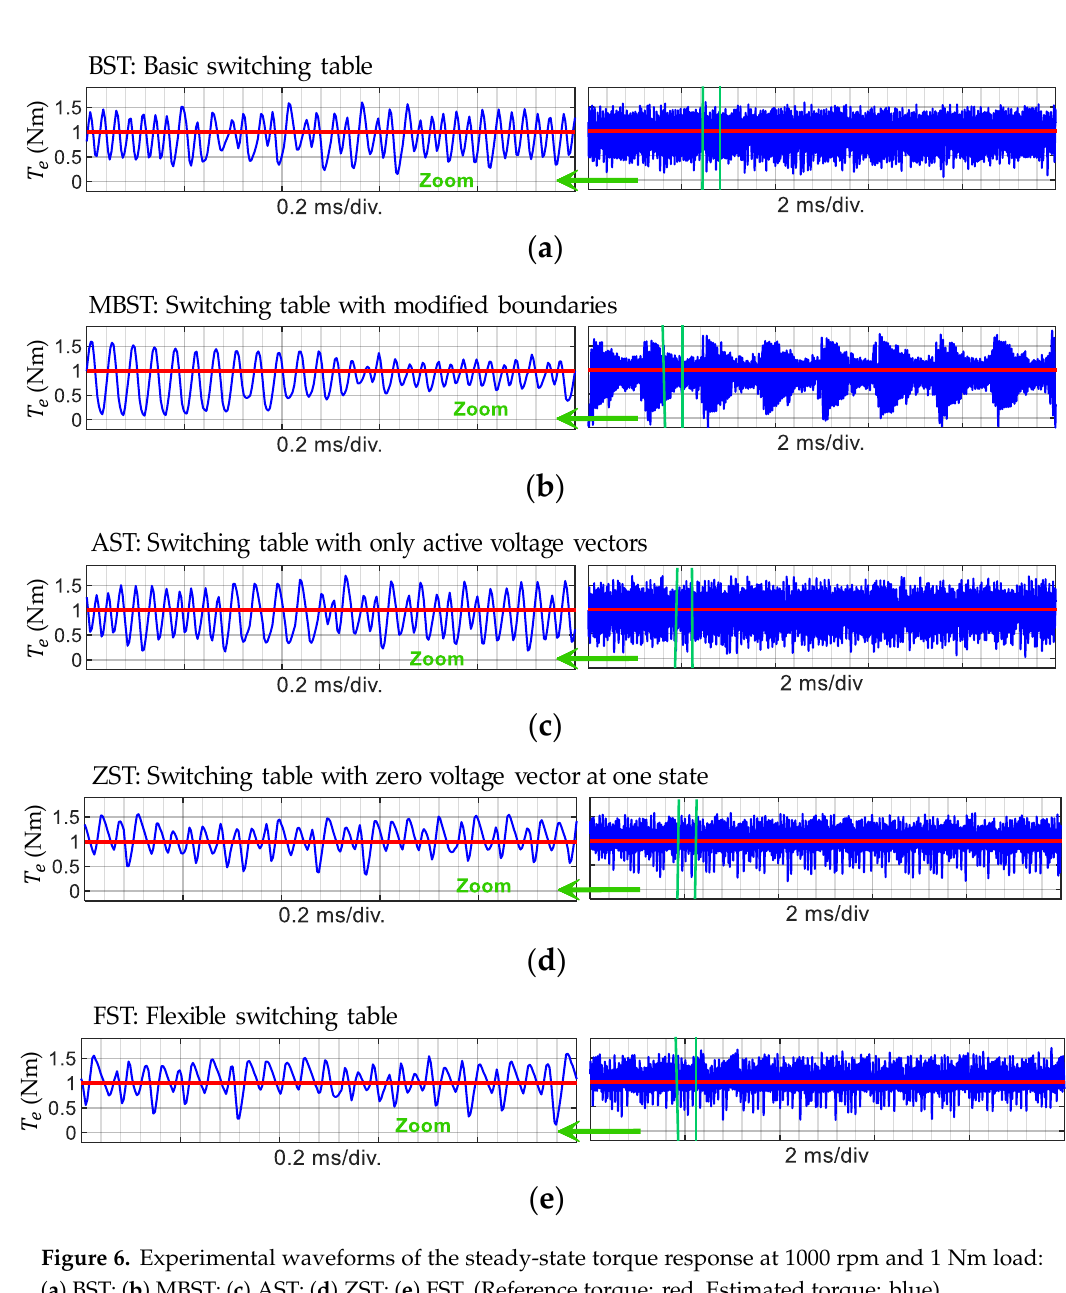
Figure 7. Experimental results of the steady-state response of stator flux at 1000 rpm and 1 Nm load: ( a ) BST; ( b ) MBST; ( c ) AST; ( d ) ZST; ( e ) FST.